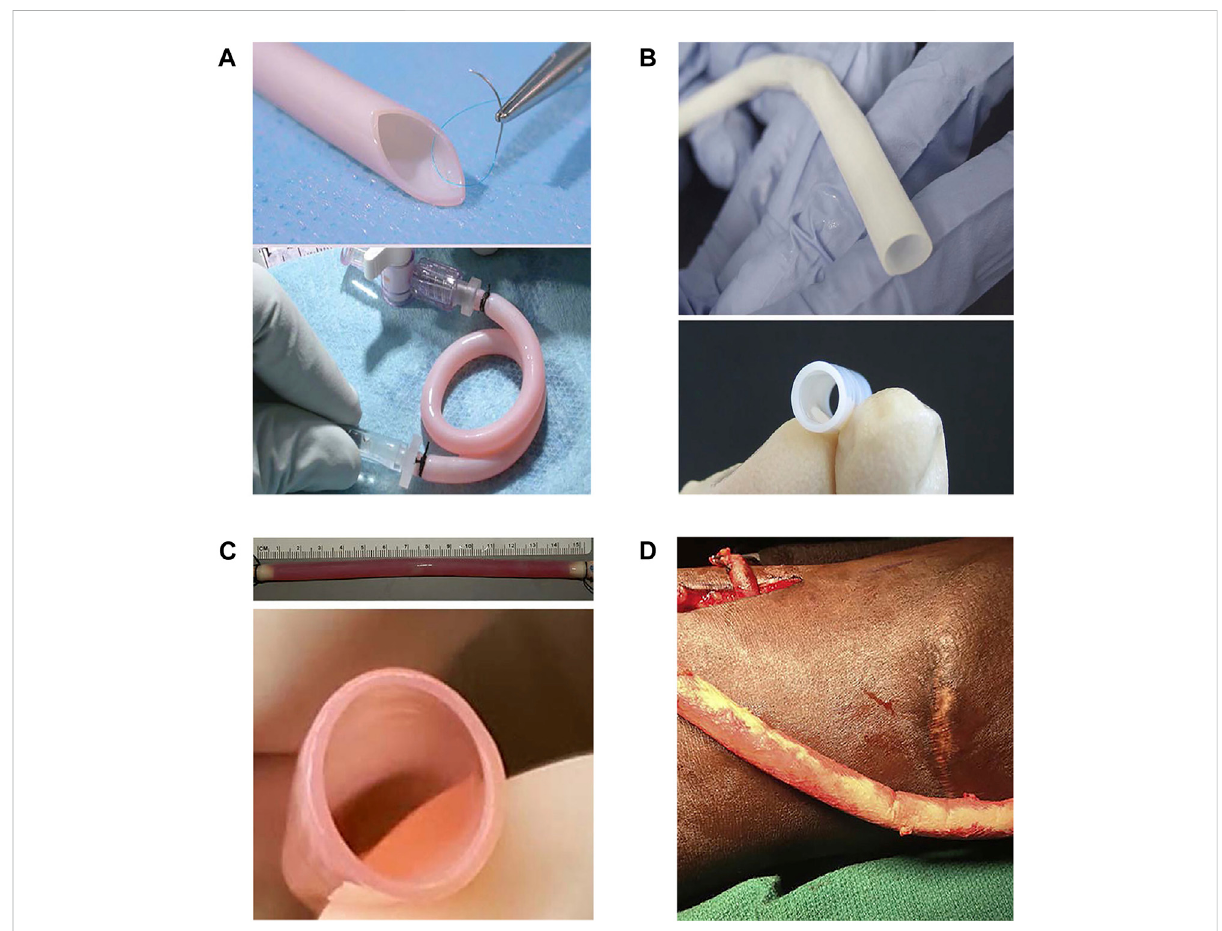
FIGURE 5 Representative products of four companies. (A) Cytograft Tissue Engineering Inc. — The Lifeline ™ graft: a completely biological, living, and autologous human blood vessel. The Lifeline ™ graft displays remarkably high burst pressure, even though it contains no scaffolding materials, and also shows good suture retention abilities as well as remarkable fl exibility (L ’ Heureux and McAllister, 2008). (B) Humacyte, Inc., — Human acellular vessels (HAVs): gross photos of engineered human acellular vessels, 6 mm in diameter (Niklason and Lawson, 2020). (C) Vascudyne, Inc. — Arteriovenous graft (AVG): side view and end-on view image of a 6-mm-diameter decellularized tissue-engineered vascular graft (Syedain et al., 2017). (D) LeMaitre Vascular, Inc., — Artegraft ® : a bovine carotid artery (BCA) graft before tunneling (Pineda et al.,